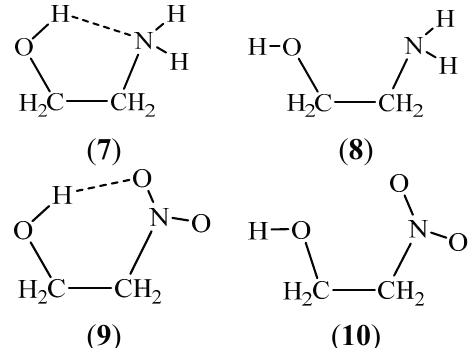
Figure 3. OCCN gauche structures with an intramolecular H-bond for 2-aminoethanol ( 7 ) and 2-NO 2 ethanol ( 9 ); Conformations 8 and 10 indicate disrupted H-bonds after rotations by approximately 120° about the O–C